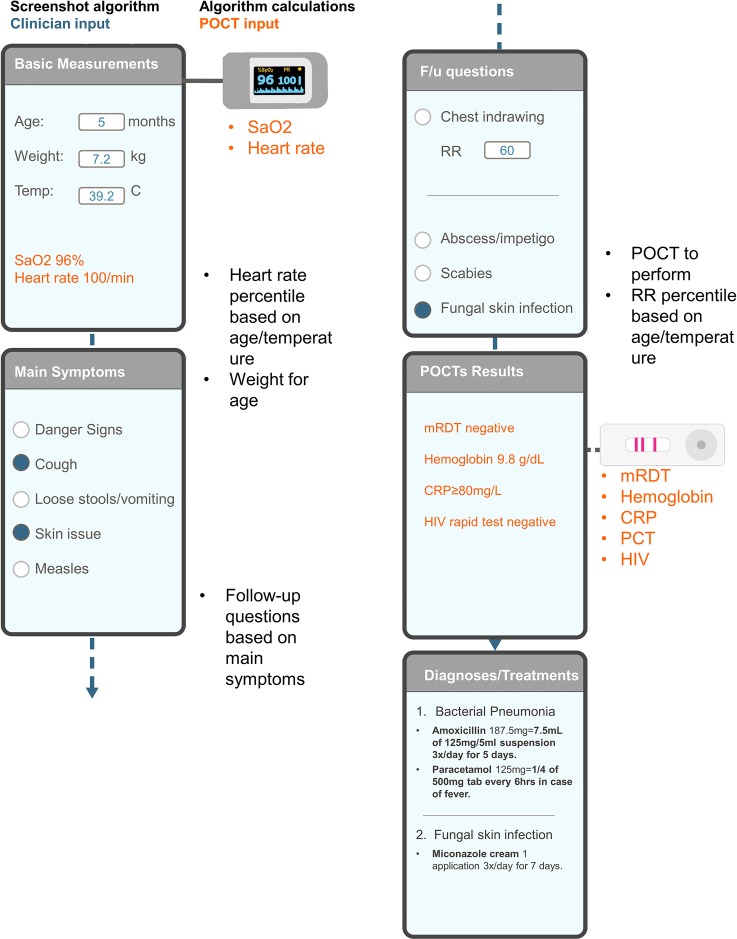
Schematic representation of the e-POCT algorithm.Example of input and output screens, sensor input, and background algorithm calculations. An example of a consultation with respective input and output screens is shown on the left; the background calculations of the algorithm are displayed on the right in black; input of information from POCTs is displayed in orange. CRP, C-reactive protein; F/u, follow-up; HIV, human immunodeficiency virus; PCT, procalcitonin; POCT, point-of-care test; mRDT, malaria rapid diagnostic test; RR, respiratory rate; SaO2, oxygen saturation.